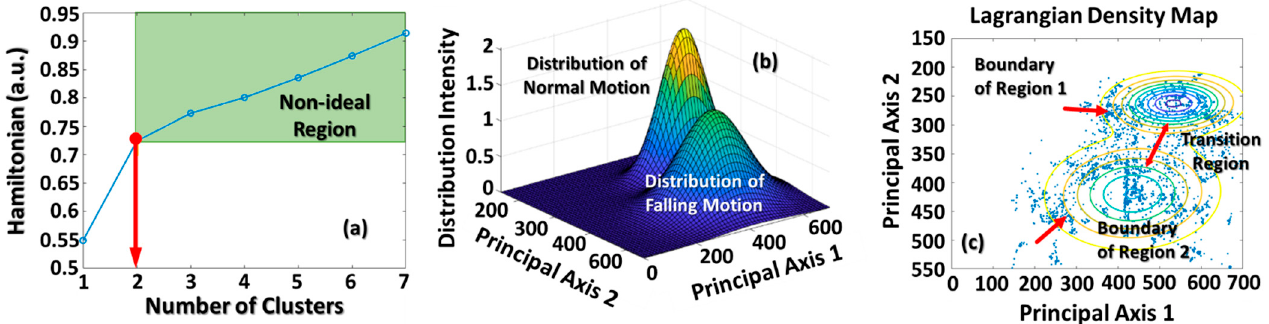
Figure 5. This figure shows ( a ) the Hamiltonian curve, where a red arrow indicates the most probable cluster number, and ( b ) the real data distributions estimated using the discrete DDFT. ( c ) The corresponding cluster boundaries of these two clusters. There is a transition region between clusters, and it represents the transition motions between normal walking and falling.